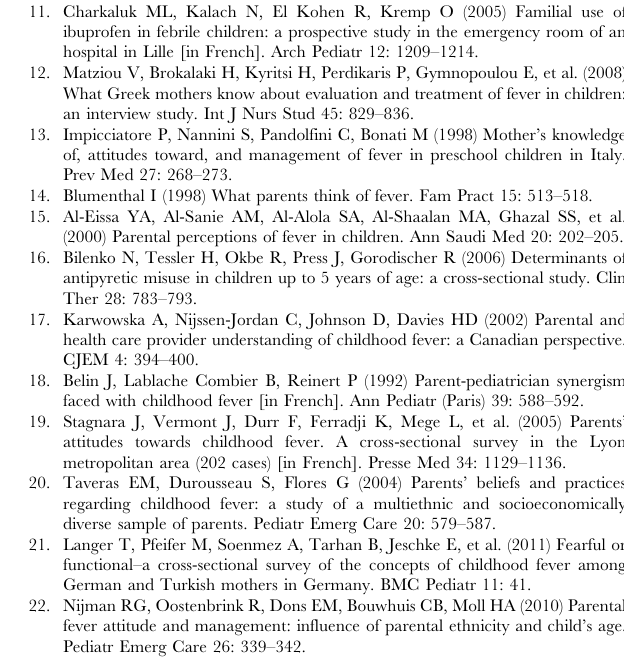
Table S1 Factors associated with temperature measurement method in parents’ concordance with recommendations for managing fever in children (rectal, aural, oral or axillary). Table S2 Factors associated with threshold for defining fever in parents’ concordance with recommendations for managing fever in children (38 u C). Table S3 Factors associated with fever threshold for starting antipyretic drug treatment in parents’ concordance with recom- mendations for managing fever in children ( $ 38.5 u C). Table S4 Factors associated with physical treatments in parents’ concordance with recommendations for managing fever in children (oral hydration, undress the child and lower the heating or aerate the room). Table S5 Factors associated with drug treatments in parents’ concordance with recommendations for managing fever in children (monotherapy in 3 to 6 doses per